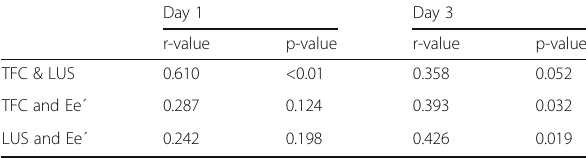
Table 57 (abstract A174). Correlation between TFC, Ee' & LUS (Day 1 & Day 3)